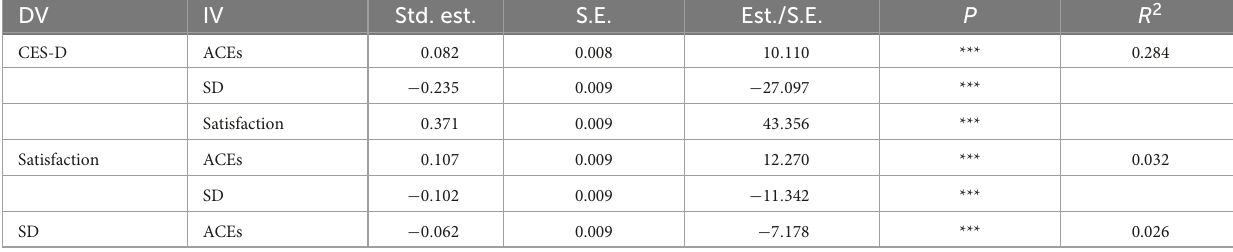
TABLE 5 Model regression weight of the impact of ACEs on CES-D scores.